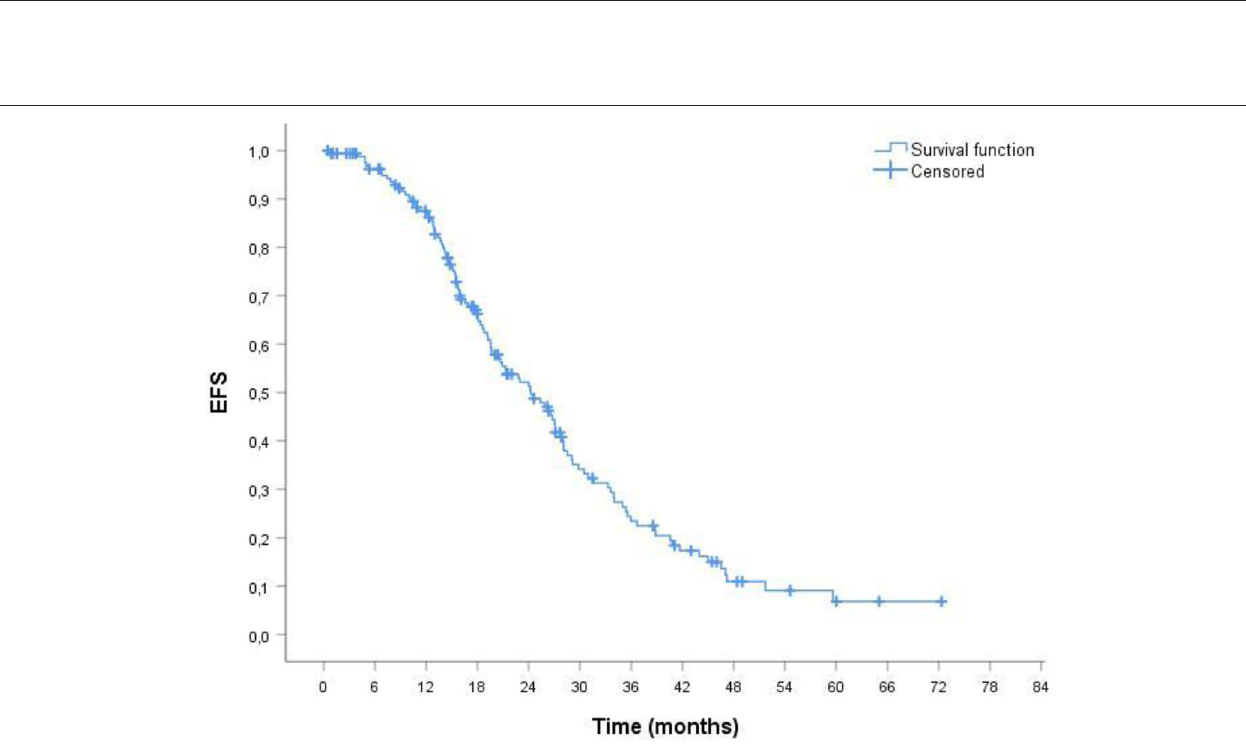
Frontiers in Medicine |